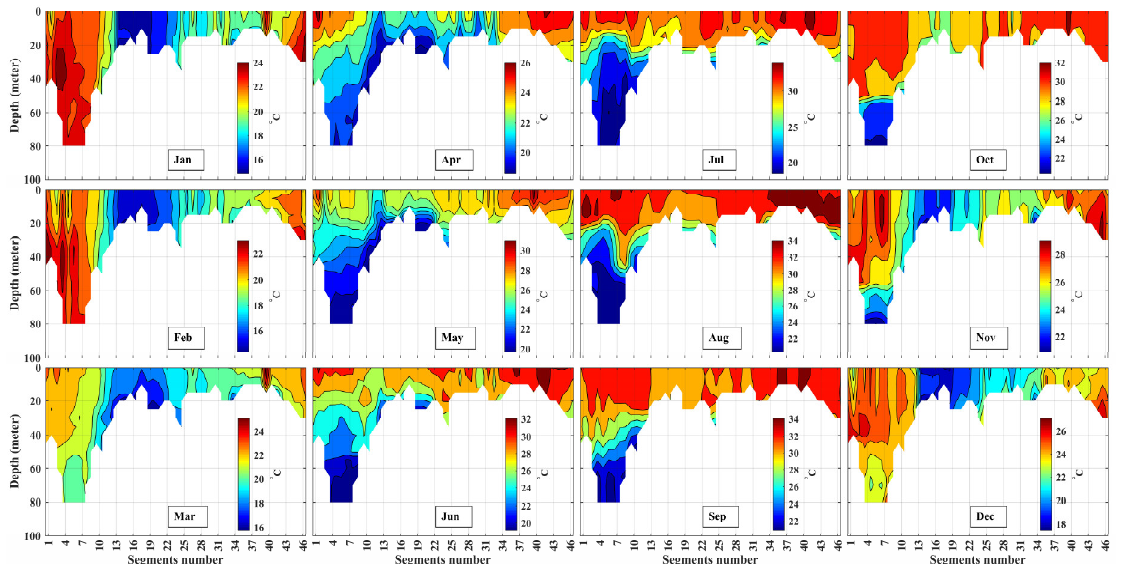
Figure 5. Intra-annual cycle of vertical variability of the temperature (1993–202 0 ).